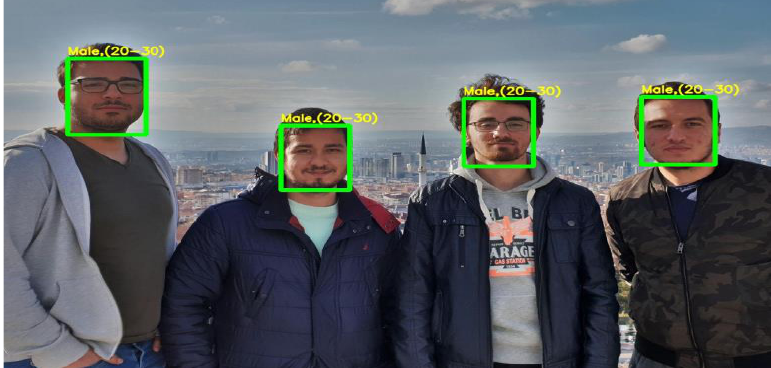
Fig. 8. The age and gender classification of four young men via CNN architecture.